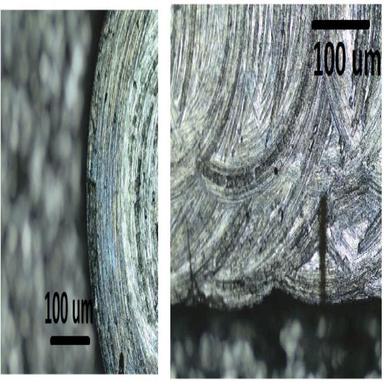
Optical microscopy images of prefabricated notched with (A) round, and (B) sharp machinig edges.